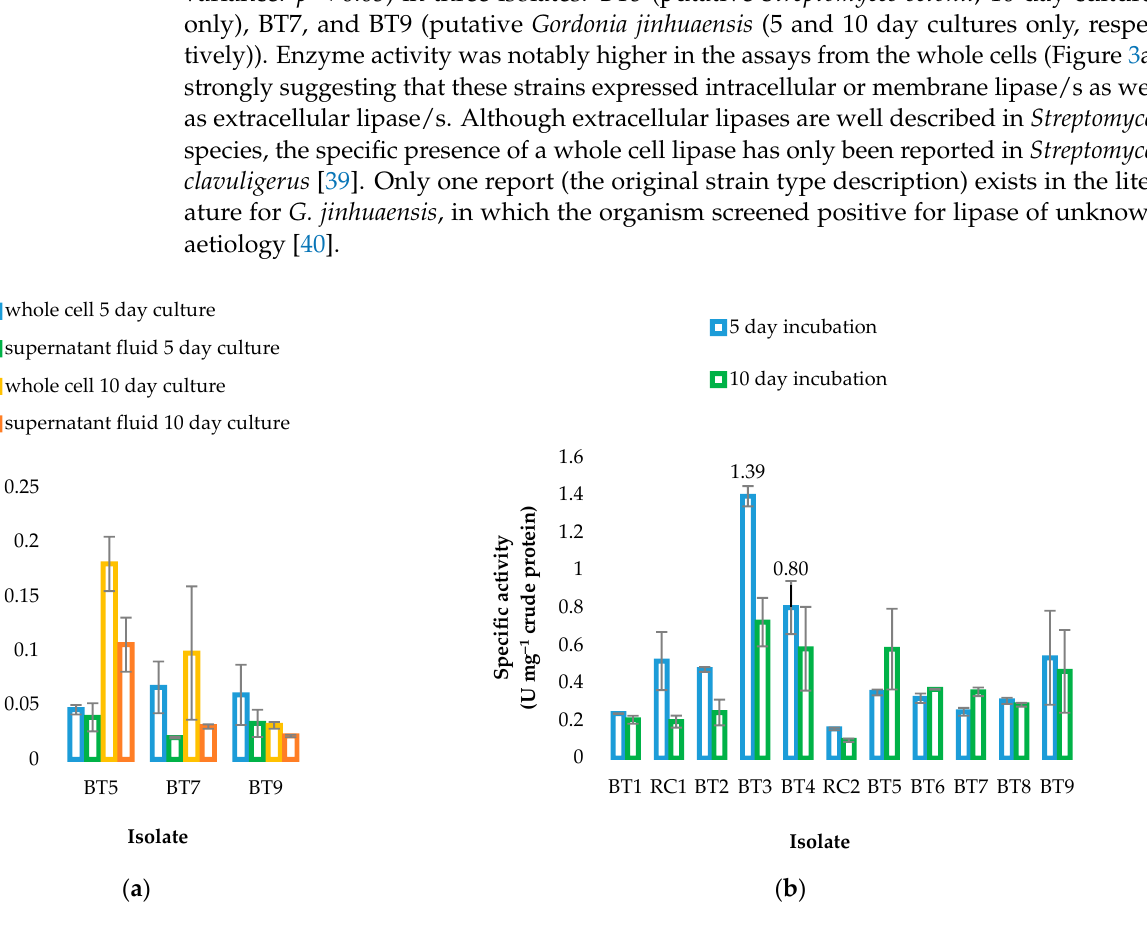
Figure 3. Differences in lipase activities in assays from whole cells and supernatant fluid ( a ), and specific lipase activities for all isolates ( b ) cultured in broth containing tributyrin and olive oil. Error bars represent standard deviation from the mean ( n = 3).